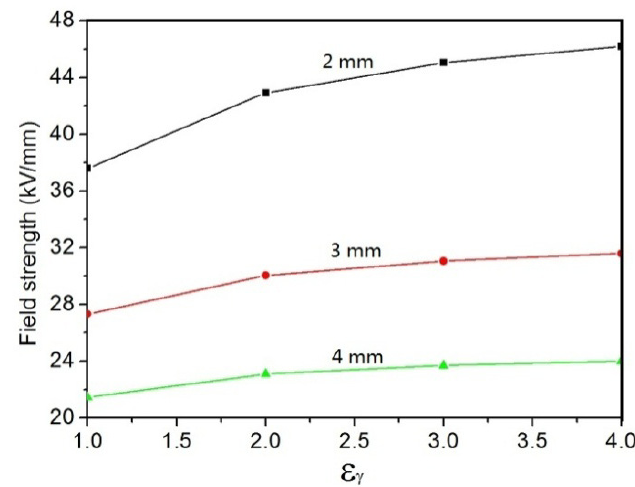
Figure 3. Effect of the relative permittivity of the insulation paper on the electric field strength ( E ) of the oil gap under three kinds of oil gap thicknesses. 1